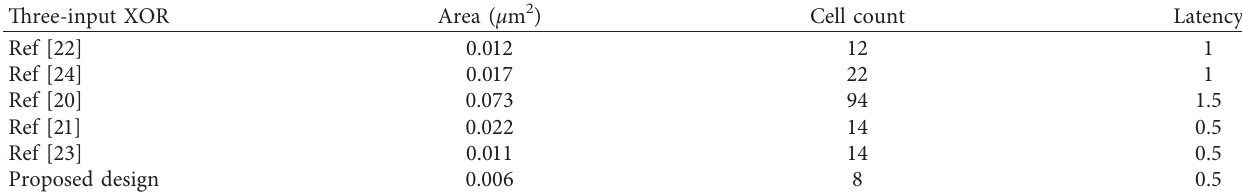
Table 3: Three-input QCA XOR gates